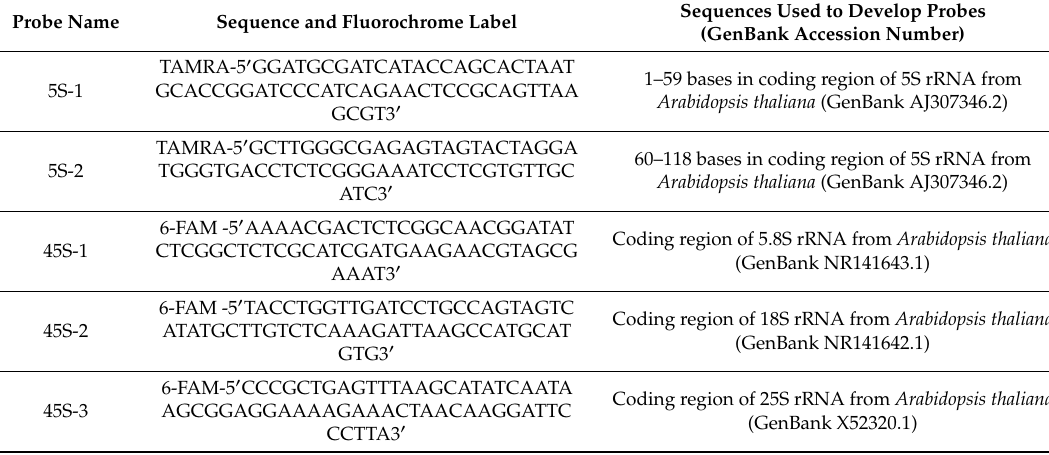
Table 2. Name, sequence, and sources of oligonucleotide probes for fluorescence in situ hybridization (FISH)